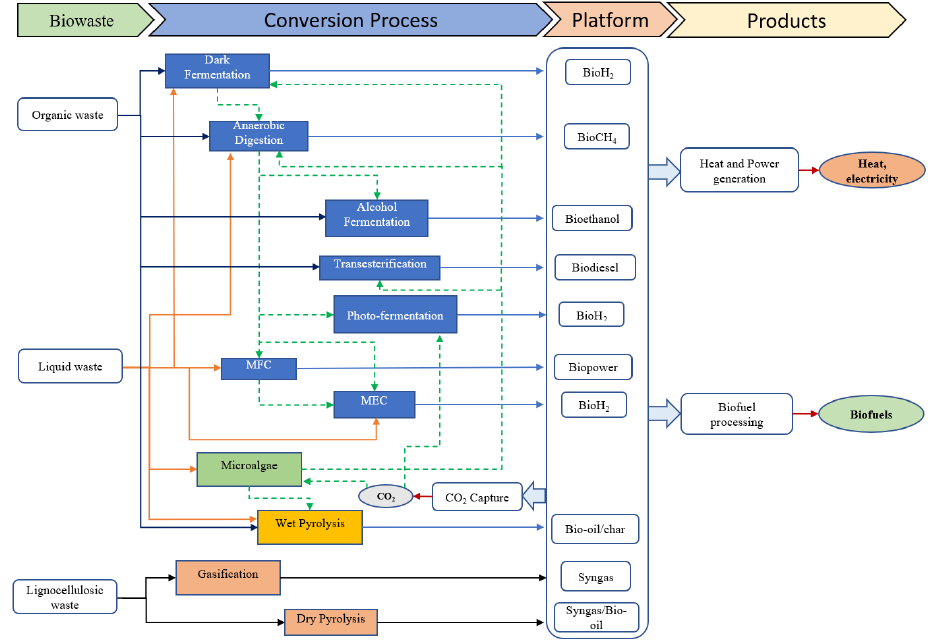
Figure 12. Pathways to bioenergy production through waste biorefineries.